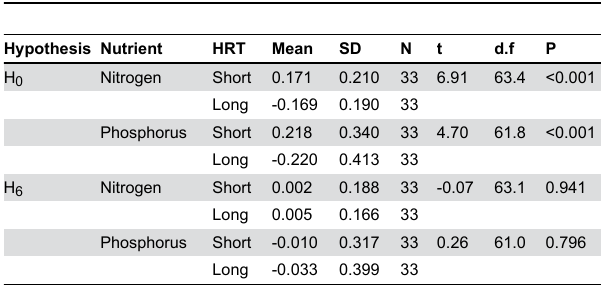
Table 2. Model selection results by hypothesis and nutrient. Nitrogen Results